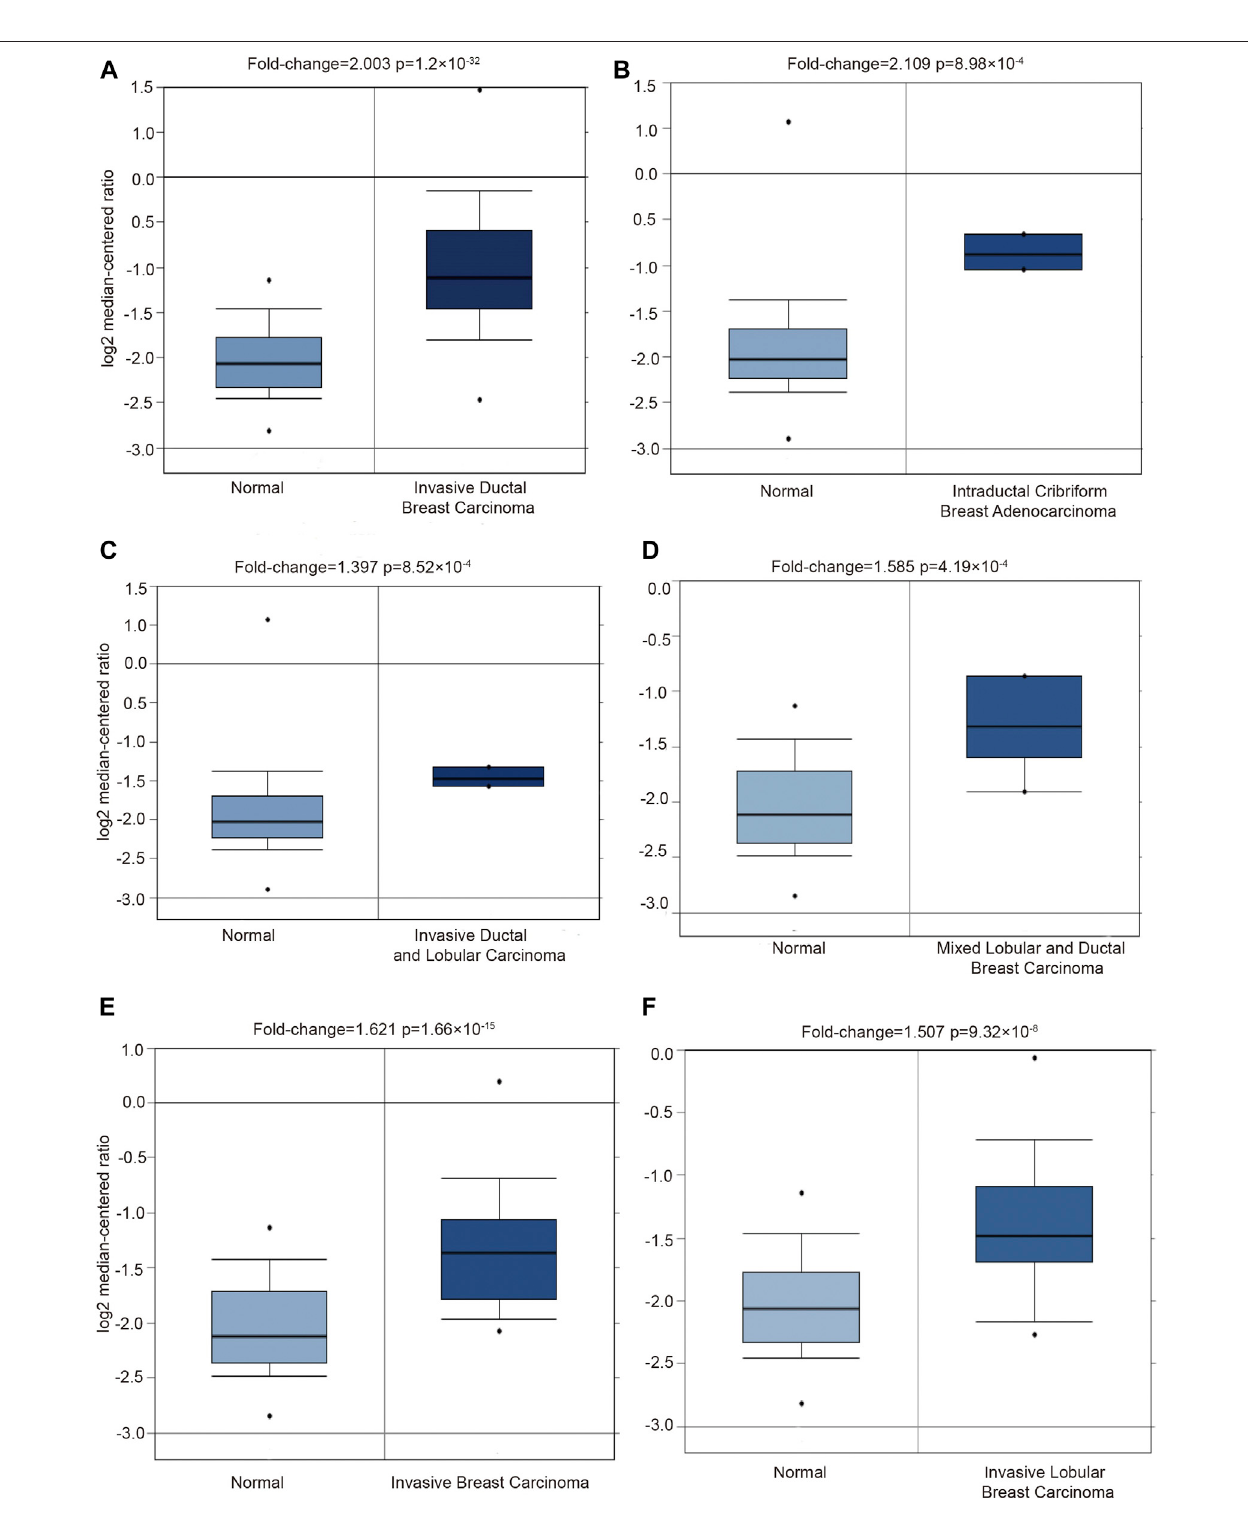
FIGURE2| DetectingthePGK1geneexpressioninsixtypesbreastcancerbyusingOncominedatabase.Sixboxplotsoriginatedfromgeneexpressiondatainthe Oncomine, comparing the expression of PGK1 in normal tissues and six types of breast cancer tissues as follows: invasive ductal breast carcinoma (A) , intraductal cribriform breast adenocarcinoma (B) , invasive ductal and lobular carcinoma (C) , mixed ductal and lobular breast carcinoma (D) , invasive breast carcinoma (E) and invasive lobular breast carcinoma (F) .